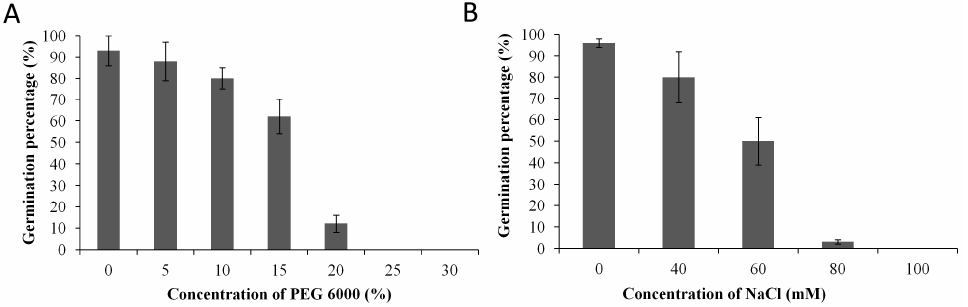
Figure 1. Pilot experiment showing the mean germination percentage of 15 sesame accessions under various concentrations of NaCl and PEG 6000. ( A ) PEG 6000; ( B ) NaCl. PEG: polyethylene glycol.